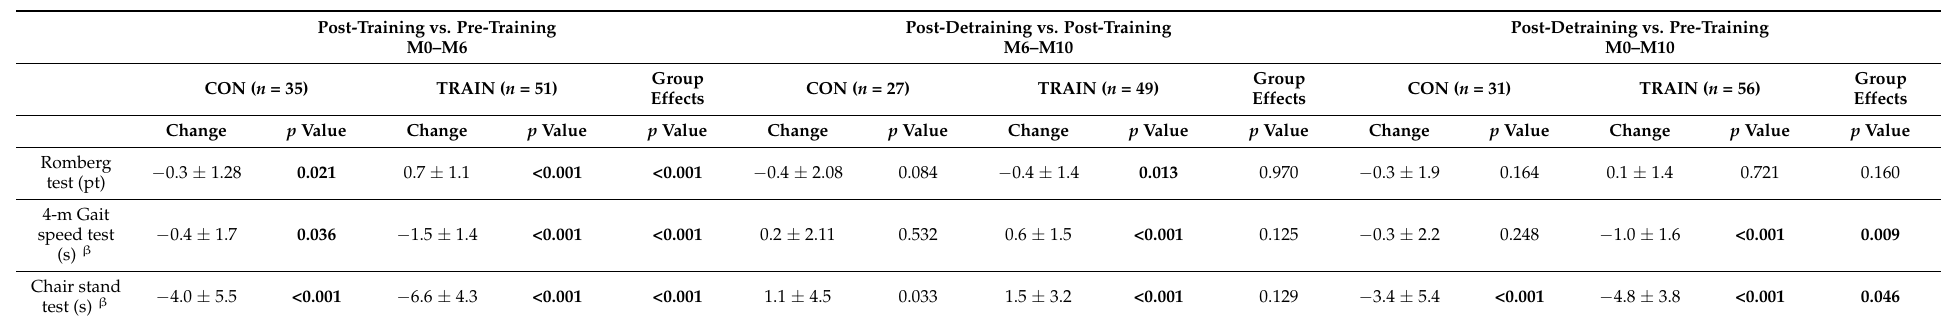
Table 4. Changes in functional capacity between and within groups in different evaluation